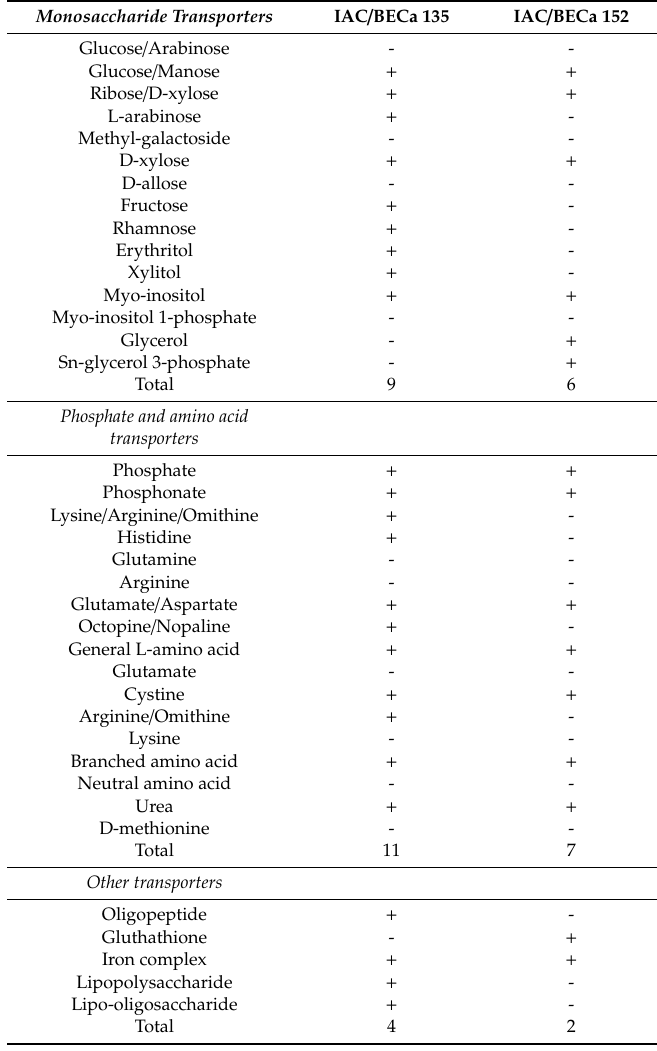
Table 4. Presence of ABC transporters in the P. tropica IAC / BECa 135 and H. frisingense IAC / BECa 152 strain